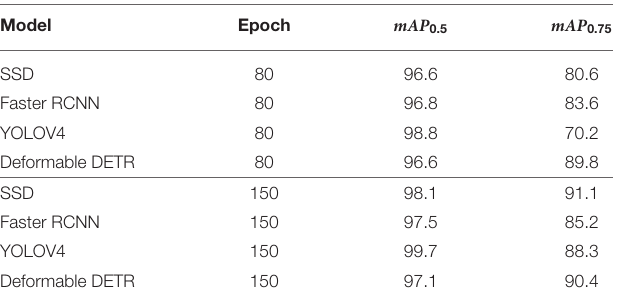
TABLE 6 | mAP α values of different models on Forestry Pest Dataset.